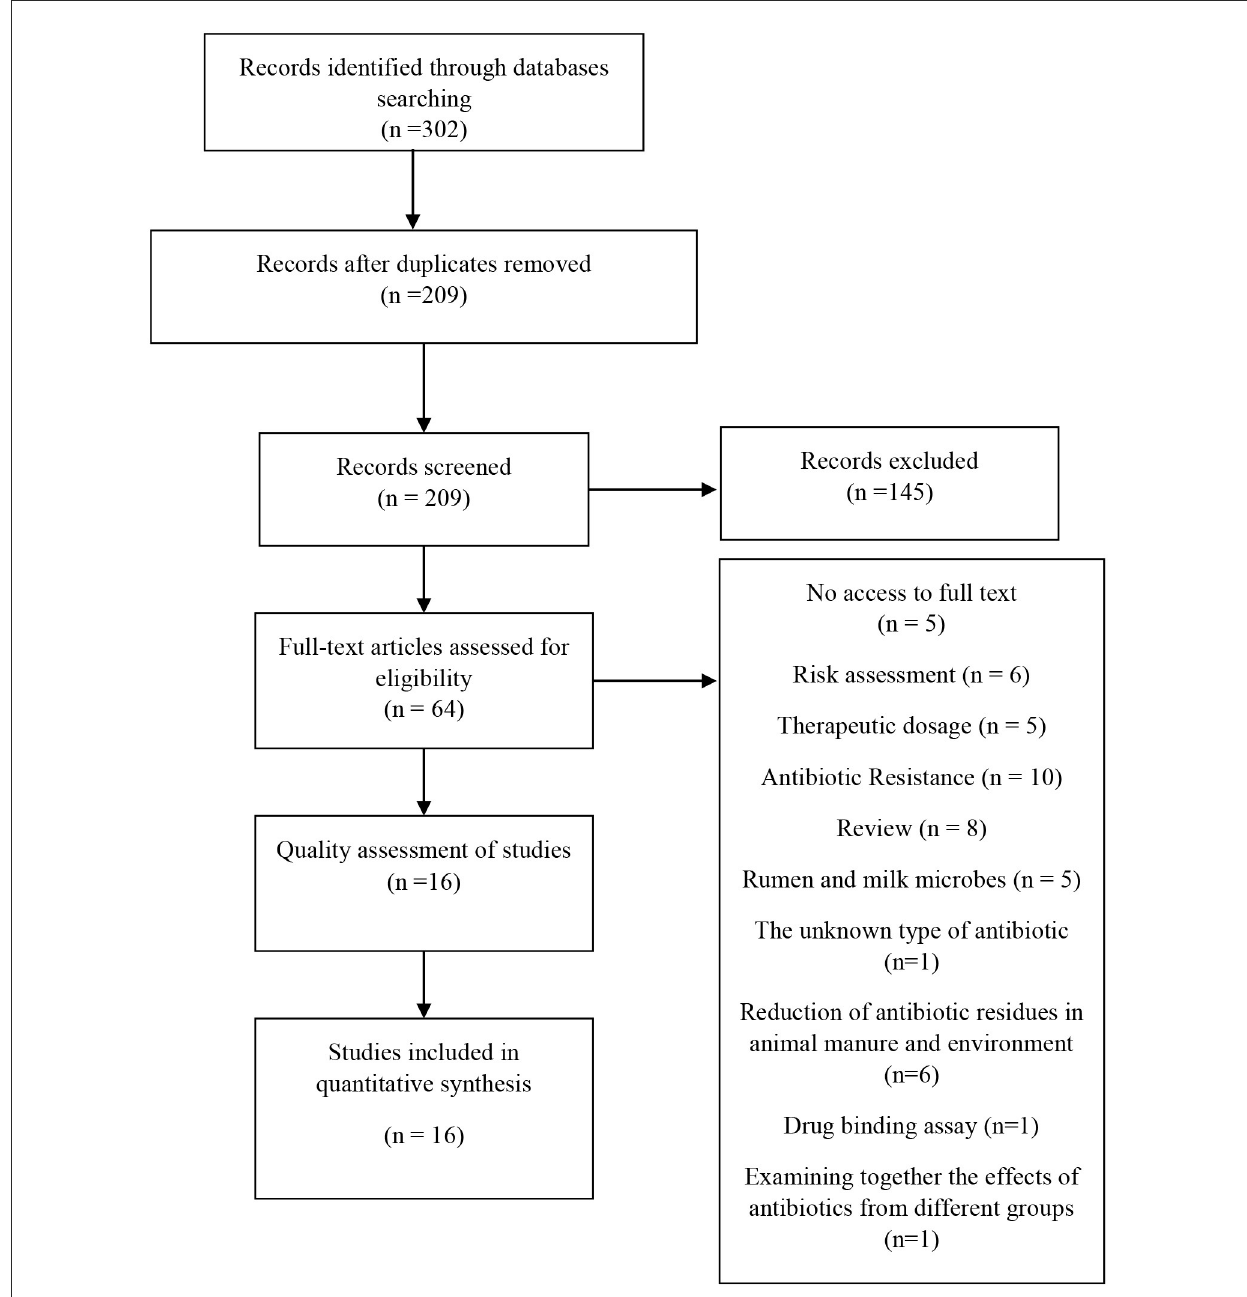
FIGURE1 The diagram of the